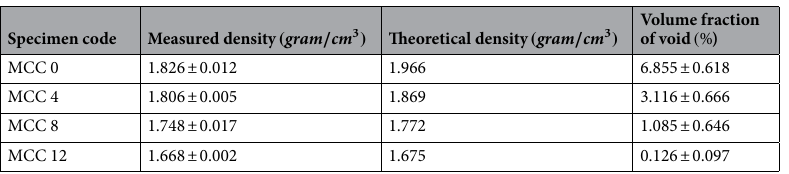
Table 3. Density and void content of the